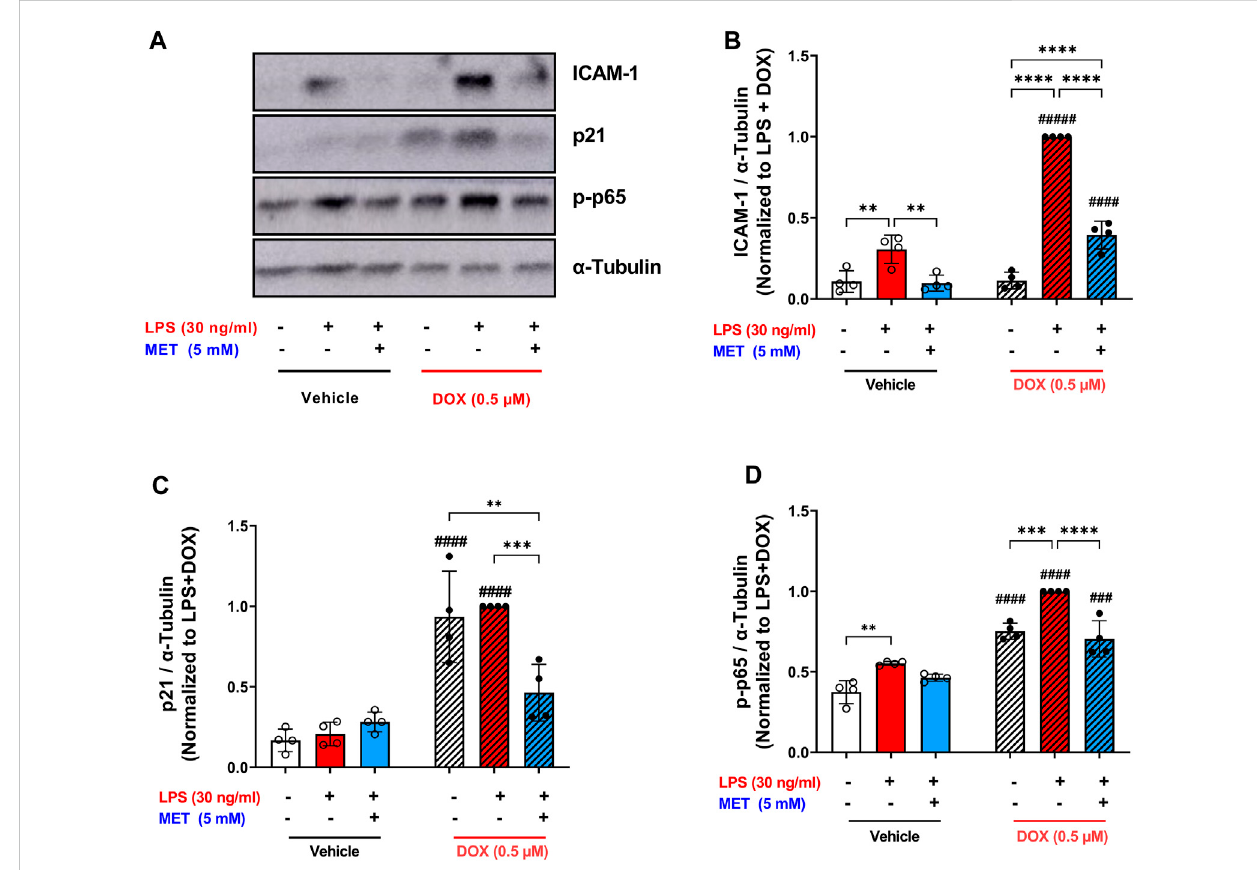
FIGURE 6 Metformin suppressed the expression of ICAM-1 and prevented NF- κ B activation following LPS stimulation. HUVECs were treated for 24 h with 0.5 µM DOX ± 5 mM metformin (added 24 h before DOX) or left untreated. Thereafter DOX was removed and the cells were incubated in DOX-free mediawithorwithoutmetforminforanadditional72 h.Then,cellswerestimulatedwithLPS(30 ng/mL)foranadditional24 h. (A) Representativeimages of western blot are shown and the expression levels of (B) ICAM-1, (C) p21, and (D) phospho-NF- κ B p65 were measured (n = 4). Values were normalized to α -tubulin and expressed relative to DOX + LPS treated cells. Expressed values are presented as mean ± SEM. Data were analyzed by two- way ANOVA followed by a Tukey multiple comparisons test. * compared to different treatment within the same group; ** p < 0.01, *** p < 0.001, **** p